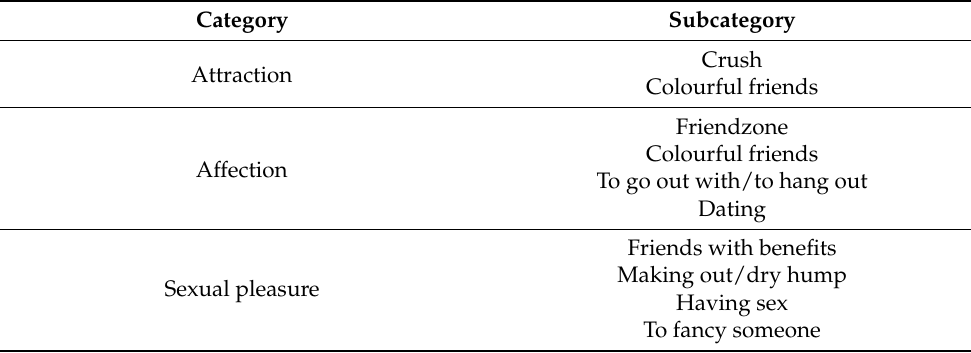
Table 4. Factors for establishing a